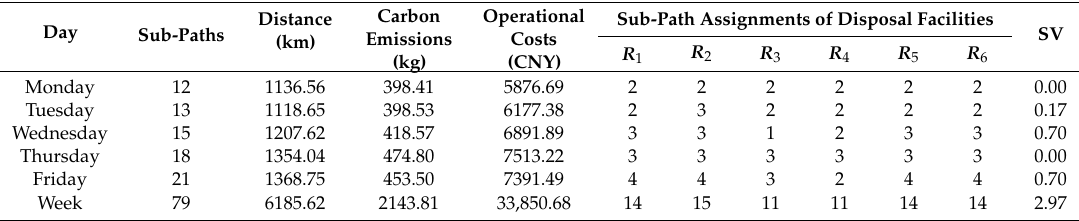
Table 13. Results of model 2: Minimized operational costs, carbon emissions, and penalty costs. Table 12. Results of model 1: Minimized operational costs and carbon emissions.